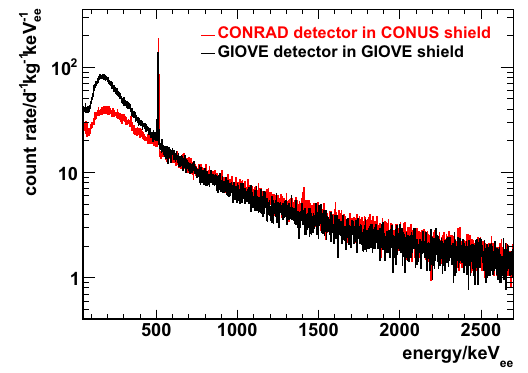
Fig. 7 Comparison of MC of μ -induced signals to highE data of C1 without applied μ -veto (corrected for other non- μ -induced back- ground). Above 100keV ee , an excellent agreement is achieved. The red spectrum corresponds to the electromagnetic contribution; the green spectrum relates to the neutron-induced